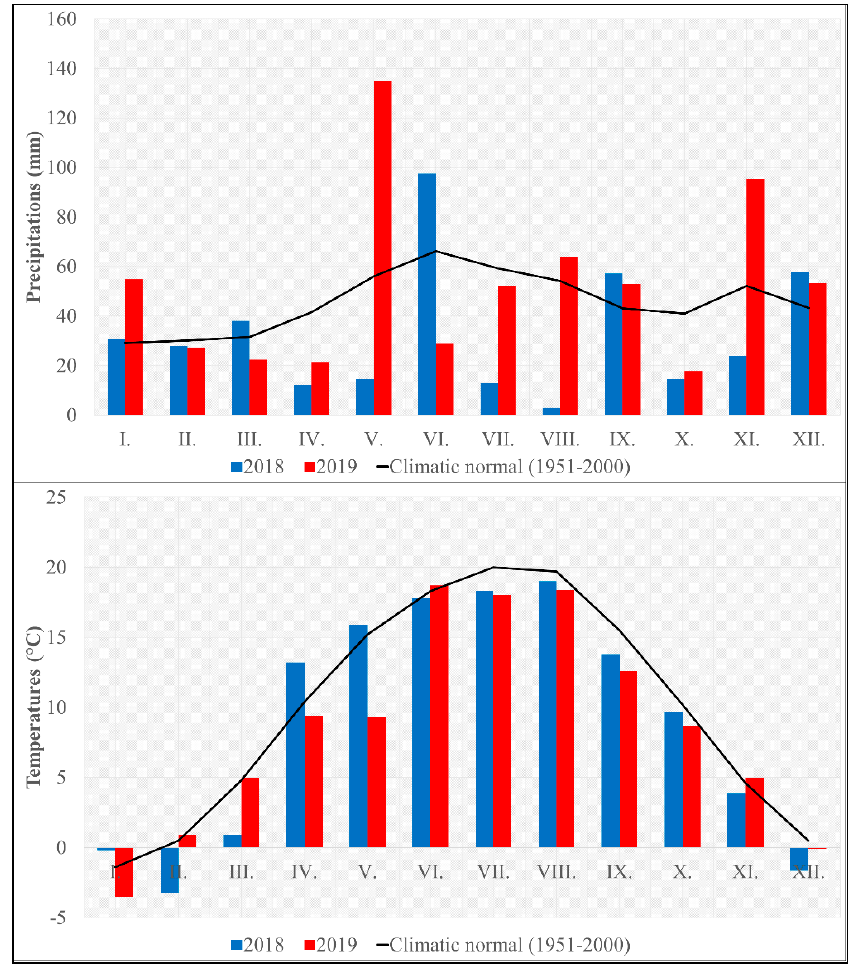
Figure 1. Precipitation (mm) and temperature (°C) variabilities of research years on experimental area. Included are long-term climatic normal values (1951 to 2000) of region. I.–XII. represent months.